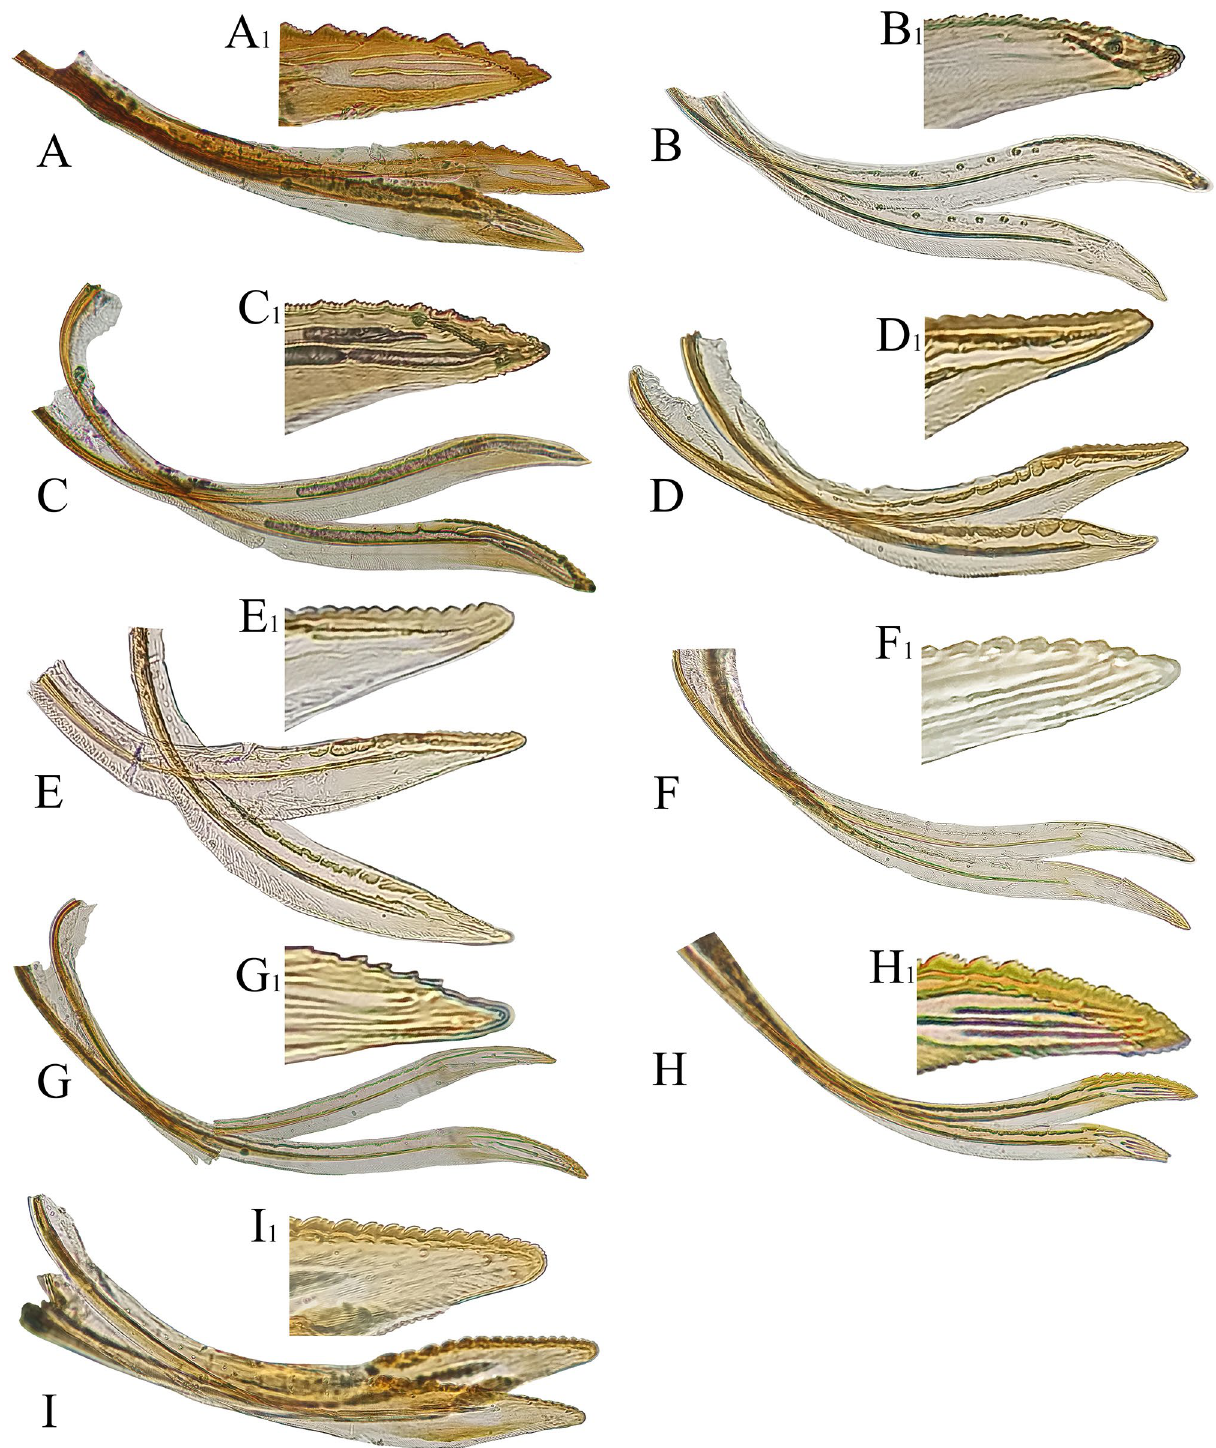
Figure 7. Female valvula II: (A–I) : (A) Mitjaevia protuberanta . (B) Empoascanara sipra . (C) Empoascanara dwalata . (D) Cassianeura cassiae . (E) Cassianeura bimaculata . (F) Eupteryx minuscula . (G) Eupteryx gracilivramus . (H) Limassolla lingchuanensis . (I) Zyginella minuta . (A 1 –I 1 ) : Enlarged